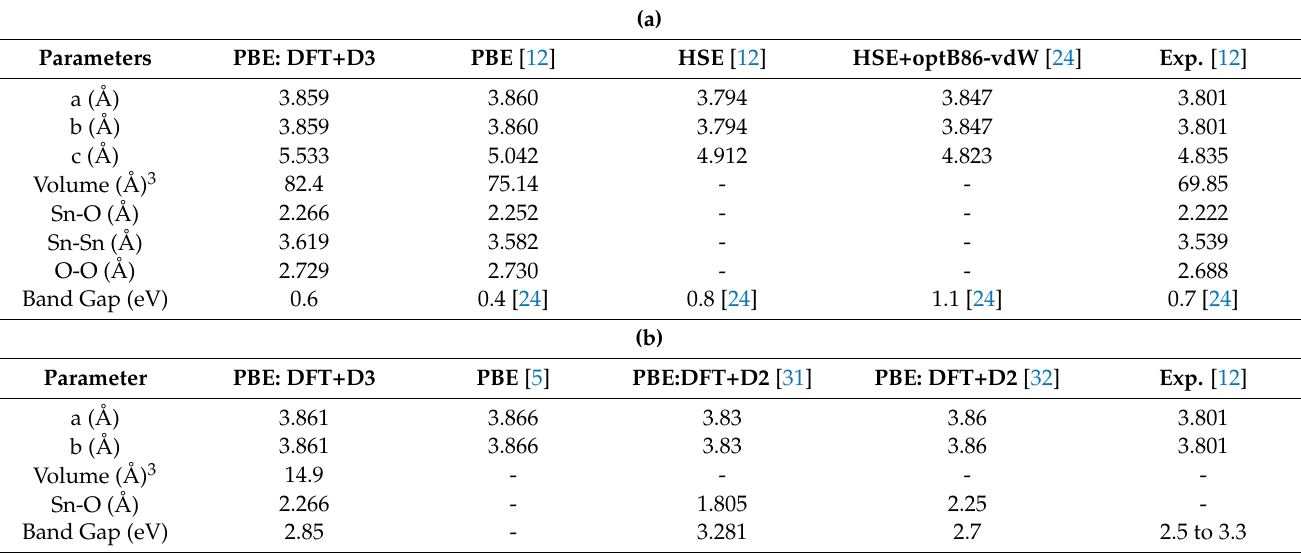
Table 2. A comparison of the calculated values with the literature values for (a): bulk SnO (b): SnO monolayer.